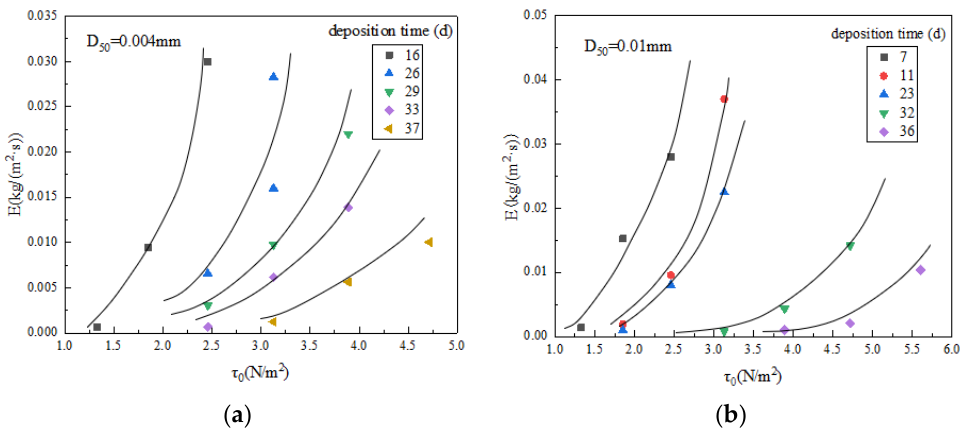
Figure 10. Relationship between shear stress and scouring rate ( a ) D 50 = 0.004 mm ( b ) D 50 = 0.01 mm.